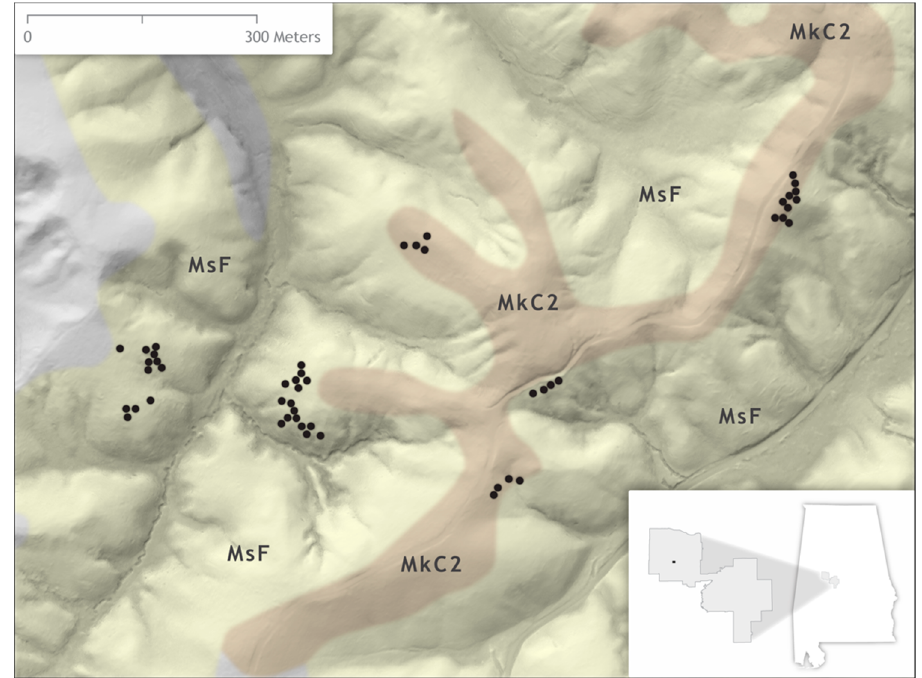
Figure 1. Map depicting the coarse woody debris (CWD) sampled on the Oakmulgee Ranger District of the Talladega National Forest, Alabama, USA expressed as black dots, and the soil map units of the study site. The MsF soil map unit represents the Maubila–Smithdale complex and MkC2 indicates areas of Maubila flaggy loam [43].